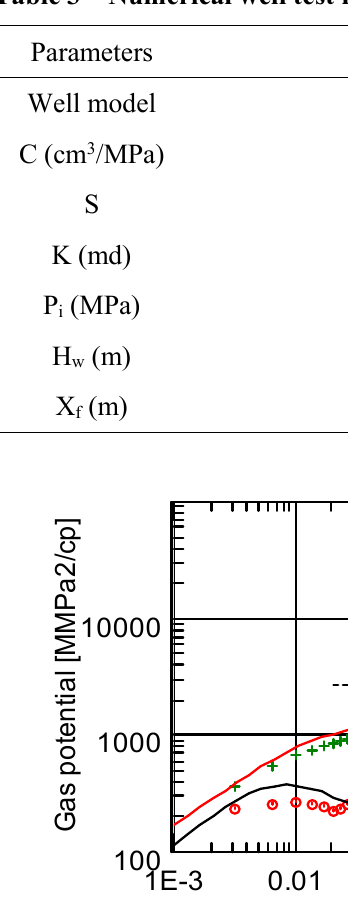
Table 3—Numerical well test interpretation results of SuA-B-CH2 well.